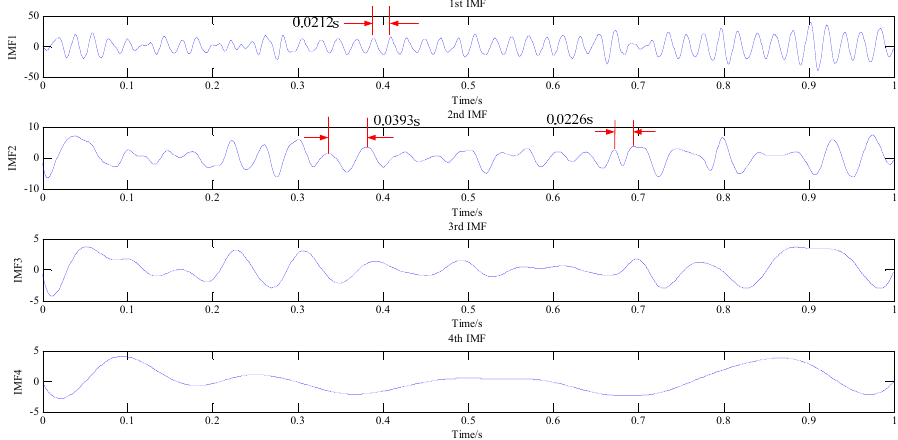
Figure 7. The decomposed first four IMFs in the time domain with 2% DE under 33% rated load.